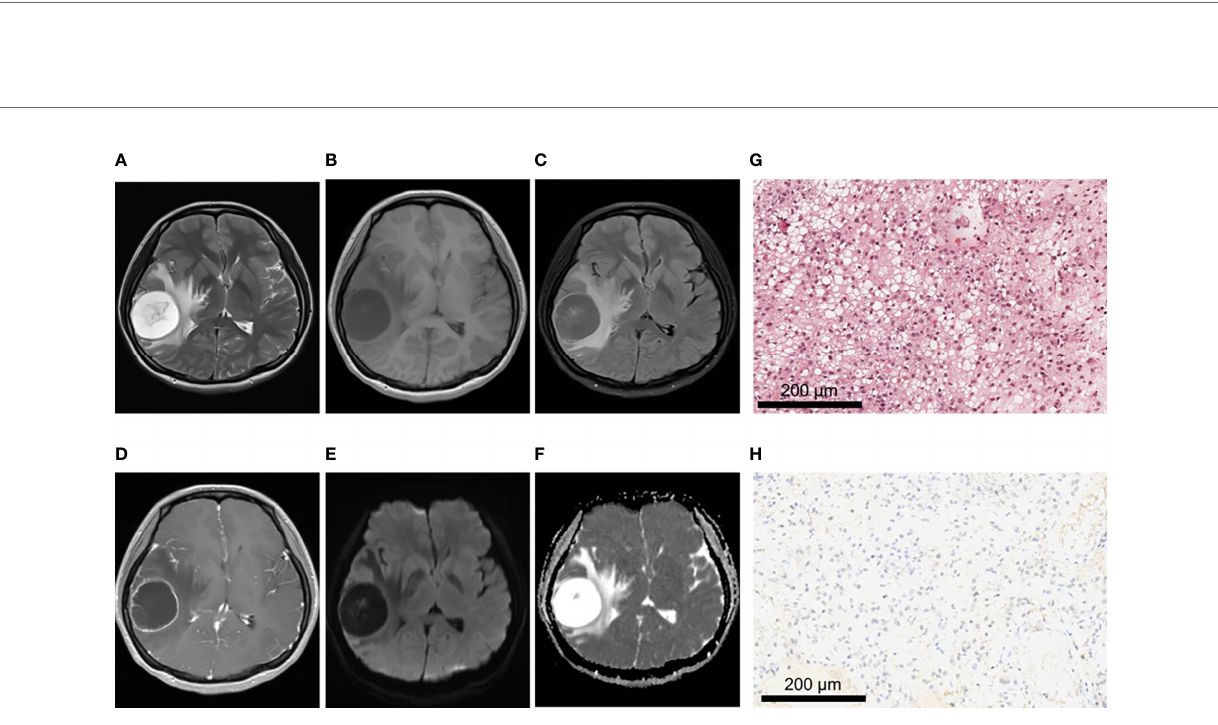
FIGURE 3 | A 21-year-old female patient with right frontoparietal temporal lobe pilocytic astrocytoma, WHO grade I, IDH-wild type. (A – C) MRI axial T2W, T1W, T2-FLAIR sequences showed clear tumor boundary, no hemorrhage, and severe edema around the tumor. (D) T1 postcontrast showed thin wall ring enhancement. (E, F) When b value was 1000, tumor was unrestricted diffusion in DWI and ADC images. (G) HE staining showed moderate cell density with oligodendrocyte like changes and a focal myxoid background (×200). (H) IDH1 negative expression (×200).